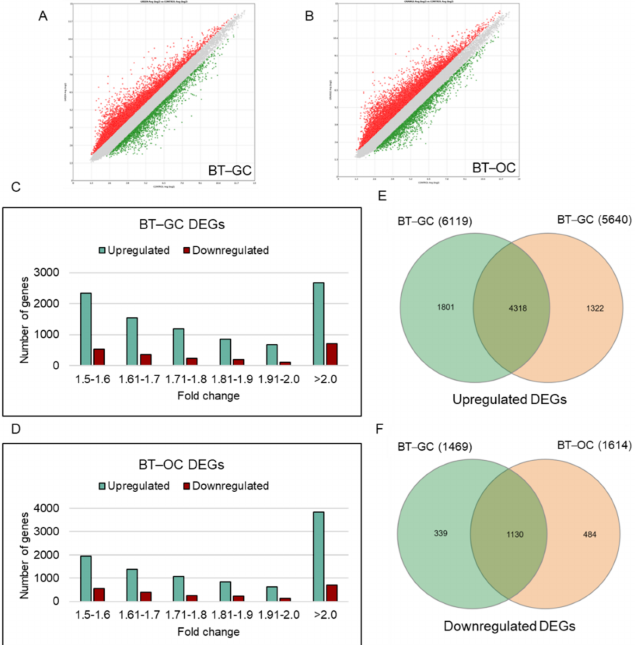
Figure 1. Distribution of fold changes of DEGs. ( A ) A volcano plot displaying the DEGs regulated between BT-GC and control. ( B ) A volcano plot displaying the DEGs regulated between BT-OC and control. These volcano plots were generated using Transcriptome Analysis Console 4 software. The red dots represent the upregulated genes whereas the green dots pertain to the downregulated genes. The gray dots are the unregulated genes. These DEGs are under the criteria of fold change >1.5 and < − 1.5. ( C ) Distribution of DEGs regulated by BT-GC and ( D ) distribution of DEGs regulated by BT-OC. ( E ) Venn diagram showing the upregulated genes of BT-GC and BT-OC and the number of overlaps. ( F ) Venn diagram showing the downregulated genes of BT-GC and BT-OC and the number of overlapping